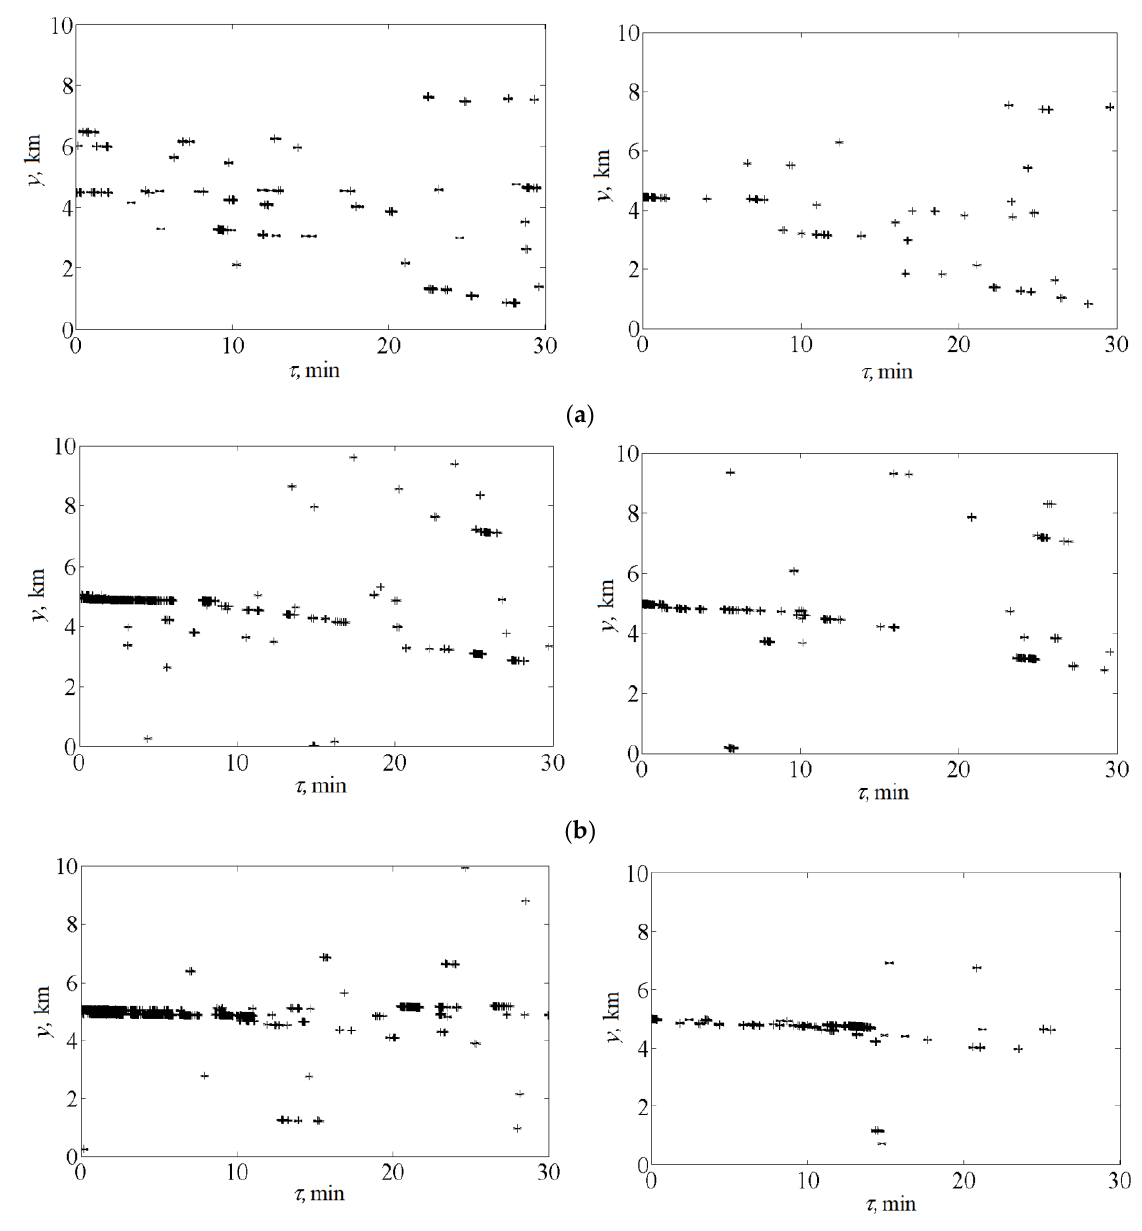
Figure 12. Spatiotemporal diagram for 𝜂 > 3 m ( left ) and 𝜂 < 3 m ( right ): ( a ) sign-variable wave; ( b ) “two sisters”; and ( c ) “three sisters”.